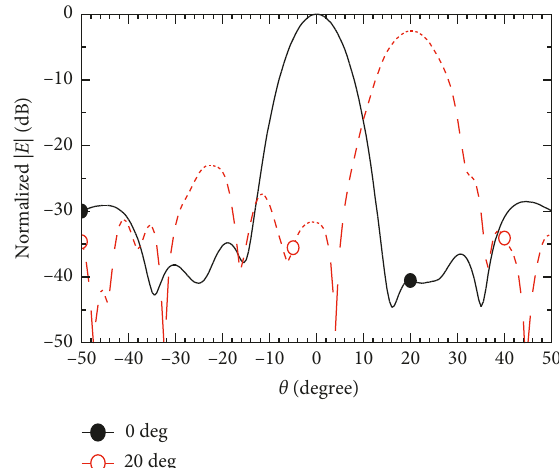
12: Measured xz -plane normalized patterns of the subarray in Mode II at 38GHz, with the main beam being in θ � 0 ° and θ � 20 ° .